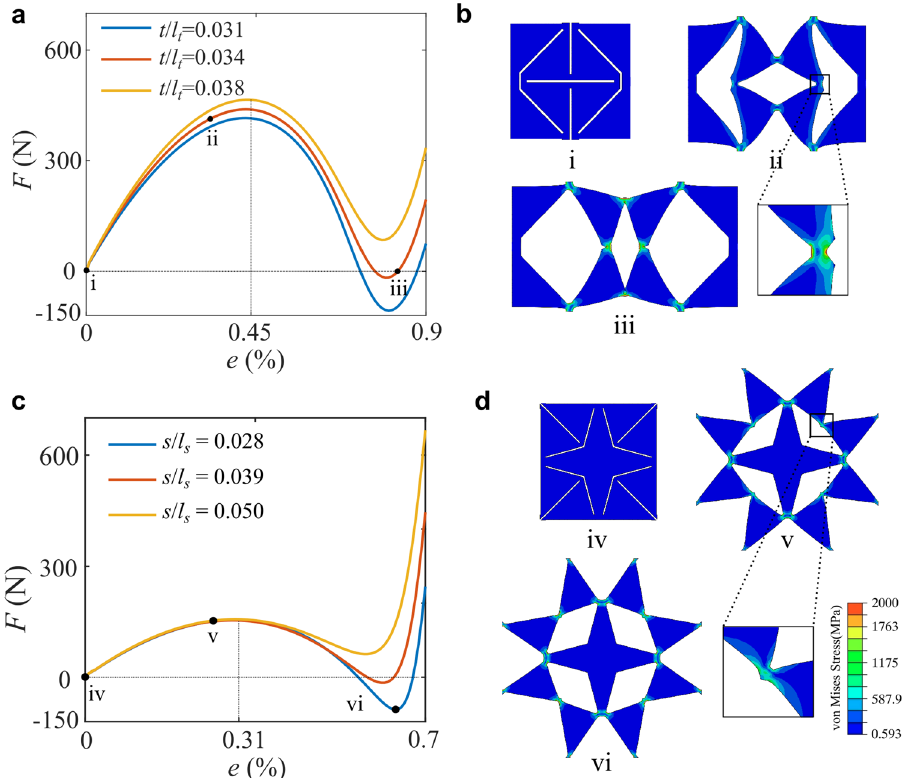
Figure 2. Bistability analysis. ( a , b ) Finite Element simulations of the triangular pattern. ( c , d ) The Finite Element simulations of the star